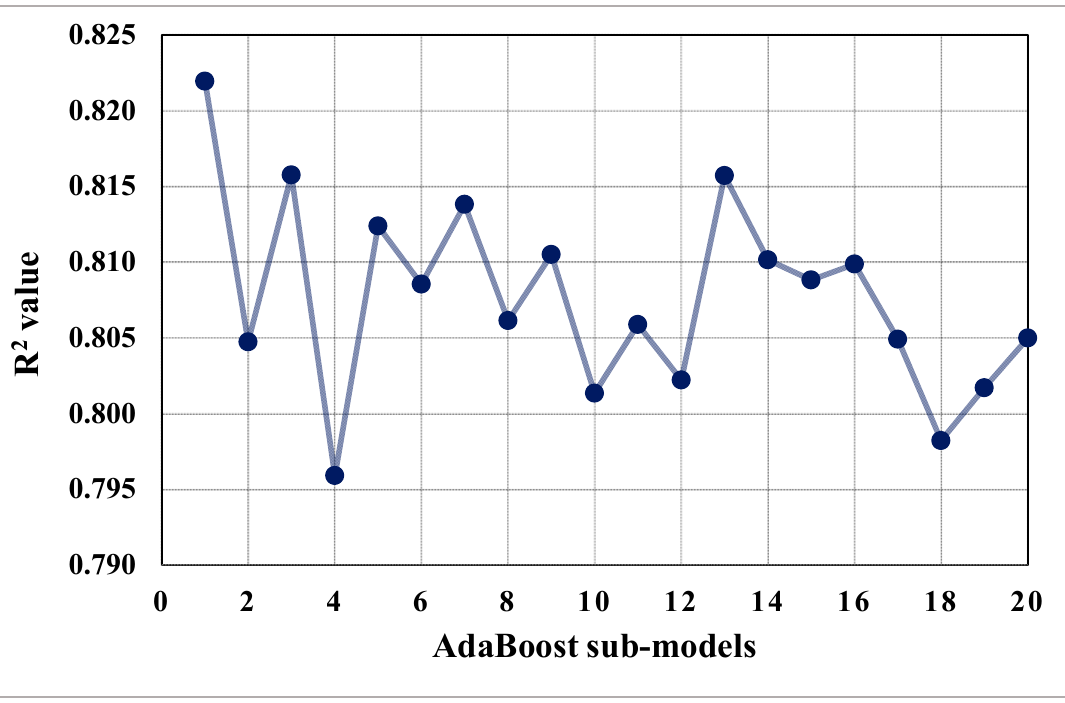
Figure 13. Coefficient of determination (R 2 ) values of AdaBoost sub-models.